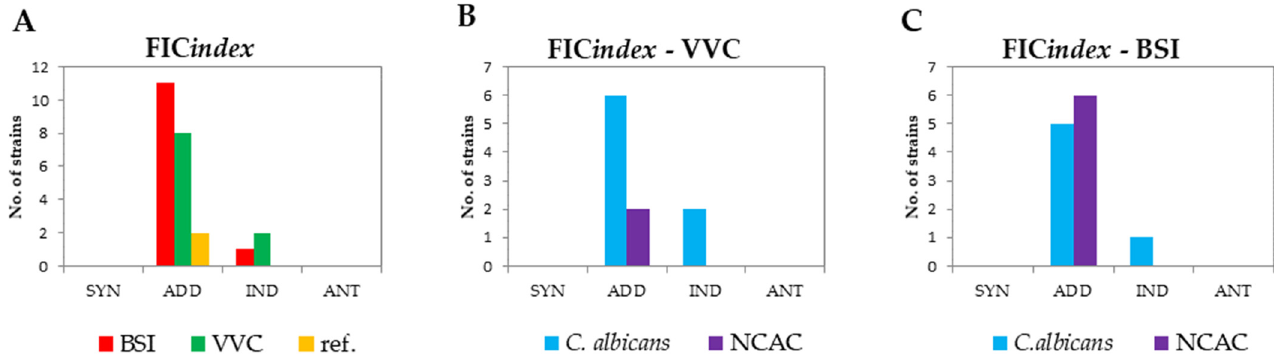
Figure 3. Cumulative FIC index results (checkerboard method) with the interpretation of the obtained effects of the fluconazole–Omiganan interaction. ( A ) Interpretation of the determined FIC indices with differentiation between vaginal (VVC) strains, blood-derived (BSI) isolates, and reference strains (marked as “ref.”). ( B ) Interpretation of the determined FIC indices against vaginal strains (VVC). ( C ) Interpretation of the determined FIC indices against the blood-derived strains (BSI).